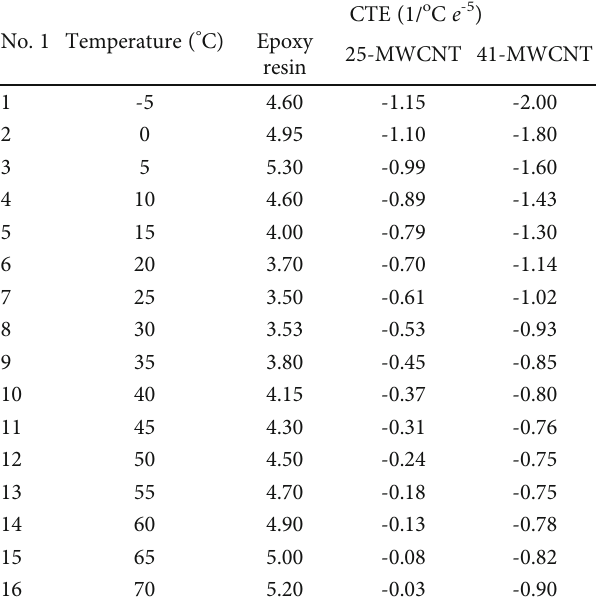
Table 2: CTEs of epoxy resin, 25-MWCNT, and 41-MWCNT at temperatures from -5 to 70 ° C [16].